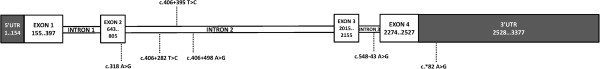
Studied variations in the genomic structure of the DKK1 gene.